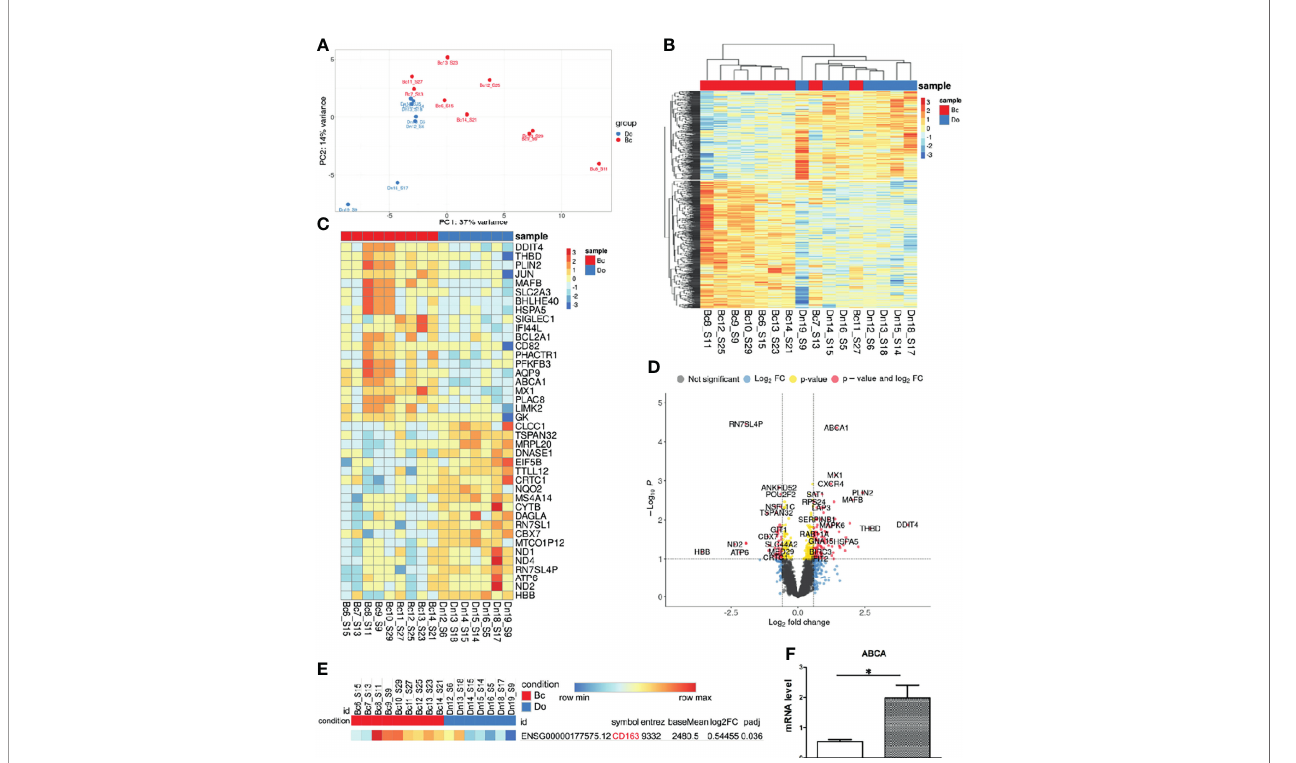
FIGURE 3 | Breast cancer alters transcriptome of circulating monocytes. (A) Principal-component analysis (PCA) plot of genes expressed in monocytes from healthy female donors (Do), n = 7, and from breast cancer patients (Bc), n = 9. (B) Hierarchical clustering of all differentially expressed genes (DEGs) between BC and healthy monocytes. Expression values are Z score transformed. Samples were clustered using complete linkage and Euclidean distance. (C) Top 20 DEG log2FC genes in healthy individuals and breast cancer patients ’ monocytes. (D) Volcano plot of RNA-Seq data breast cancer patients and healthy female monocytes. (E) CD163 DEG in breast cancer and healthy female groups. (F) Expression of ABCA1 mRNA in breast cancer patient (n = 20) and healthy female (n = 15) monocytes (independent from the RNA-seq cohort), *p-value =